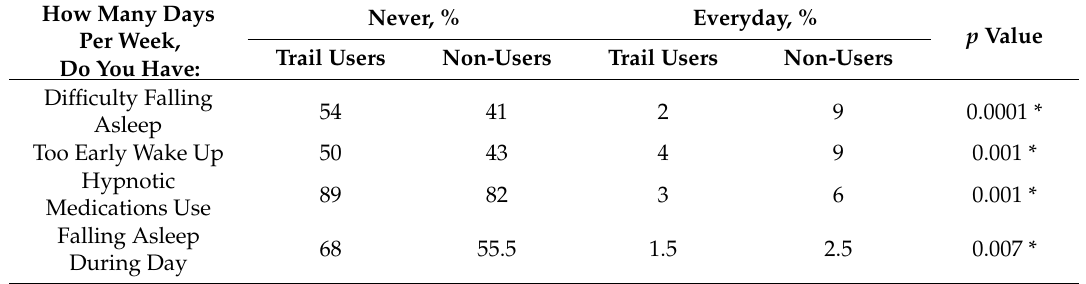
Table 2. Sleep, mood, and eating patterns compared between trail users and